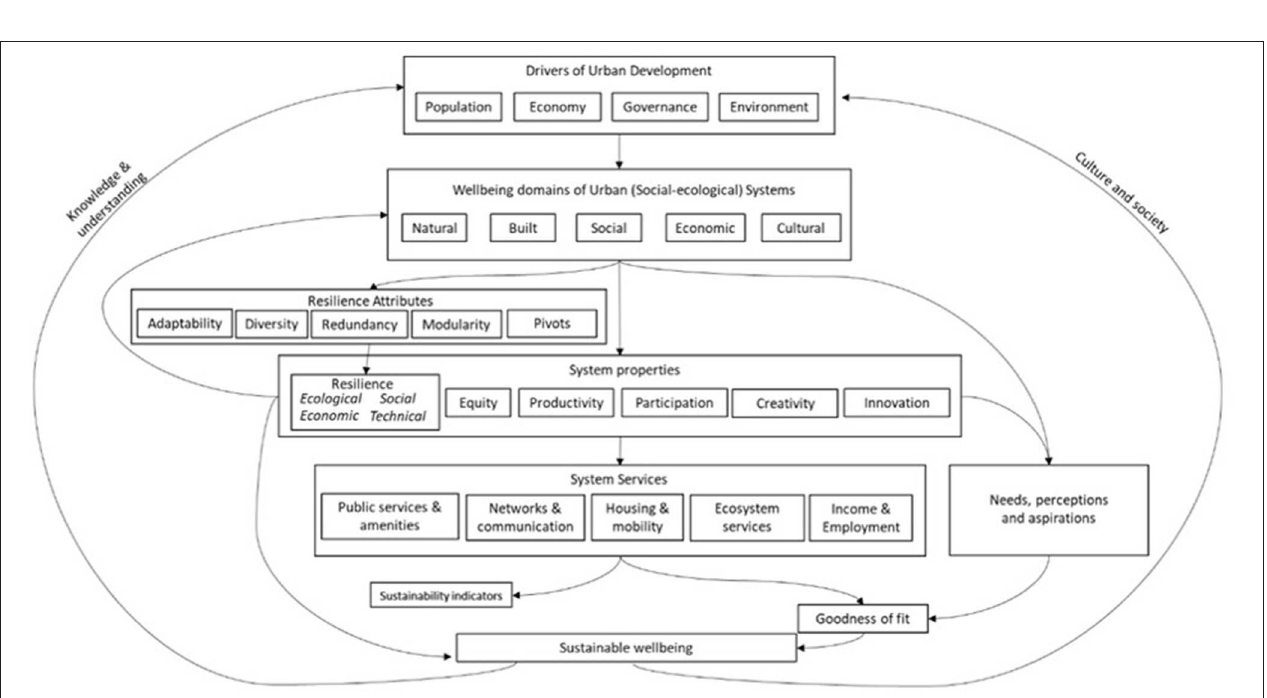
FIGURE 3 | The resilience systems framework for multidisciplinary, urban-development resilience assessment.